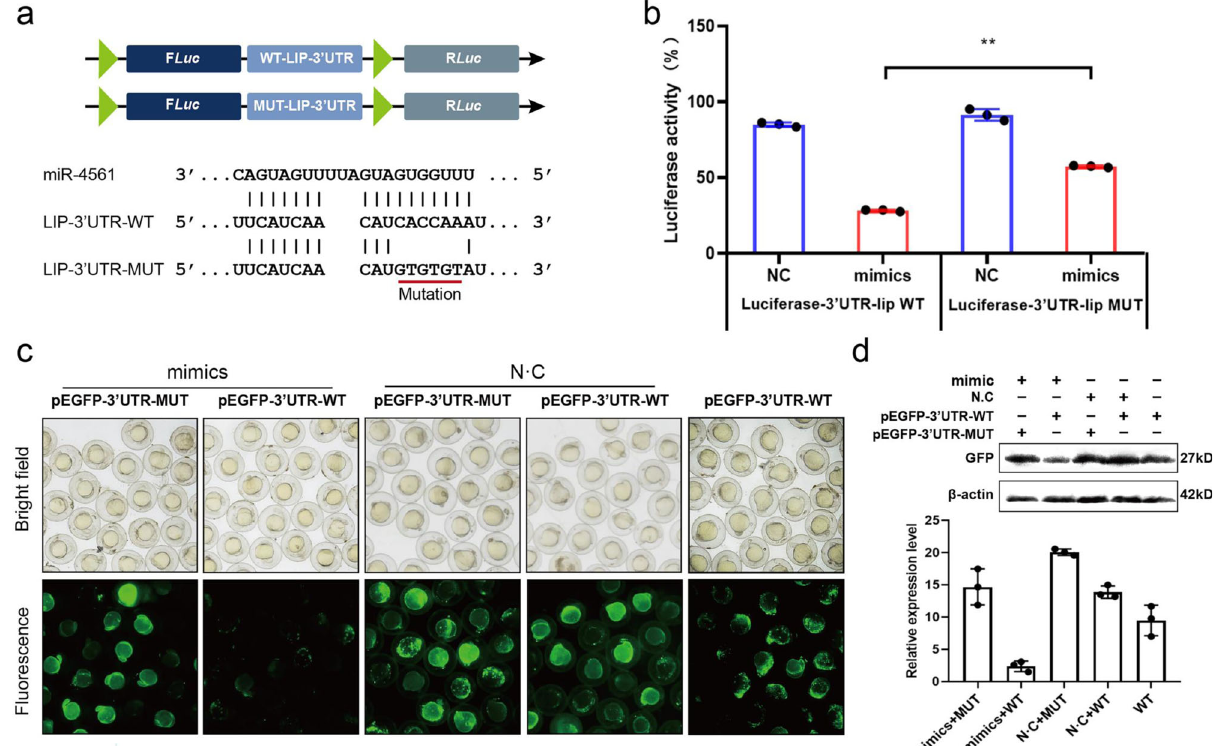
Fig. 4 miR-4561 inhibits LIP expression through direct binding to the 3 ′ -UTR of LIP mRNA. a Nucleotide sequence of the miRNA target site on lip 3 ′ - UTR. b Direct targeting of miR-4561 to lip 3 ′ -UTR as detected by the dual-luciferase method. Wild-type and mutant miRNA target sequences were cloned into dual-luciferase reporters and co-transfected into HEK293 cells with a miR-4561 mimic. Each bar represents the relative luciferase activity ( ** P < 0.01). Values shown represent the mean ± SD of three independent experiments. c Zebra fi sh single-cell embryos were injected with an EGFP reporter fused with the 3 ′ -UTR sequence, either wild-type or mutated in the presence or absence of miR-4561. Fluorescence levels were detected after 1 day. d Embryos treated as in ( c ) were lysed and the EGFP levels were measured by western